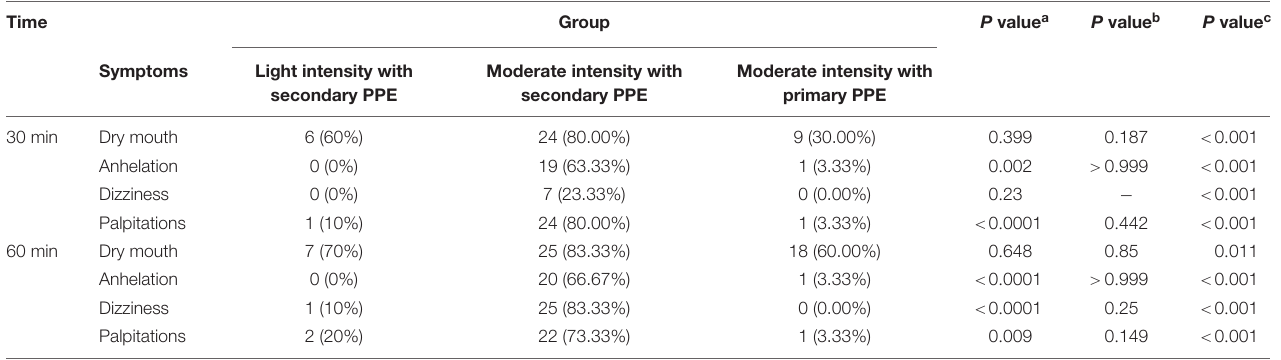
TABLE 3 | Comparison of subjective symptoms of participants between light intensity with secondary PPE and moderate intensity with secondary or primary PPE after initiation of trial at 30 and 60 min. Time Group P value a P value b Symptoms Light intensity with Moderate intensity with Moderate intensity with secondary PPE secondary PPE primary PPE